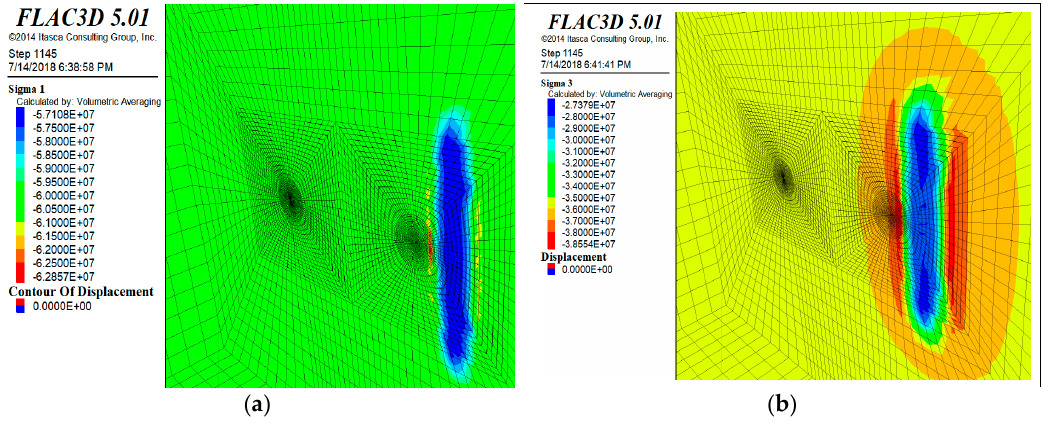
Figure 9. Principal stress concentration during initial condition: ( a ) maximum and ( b ) minimum.